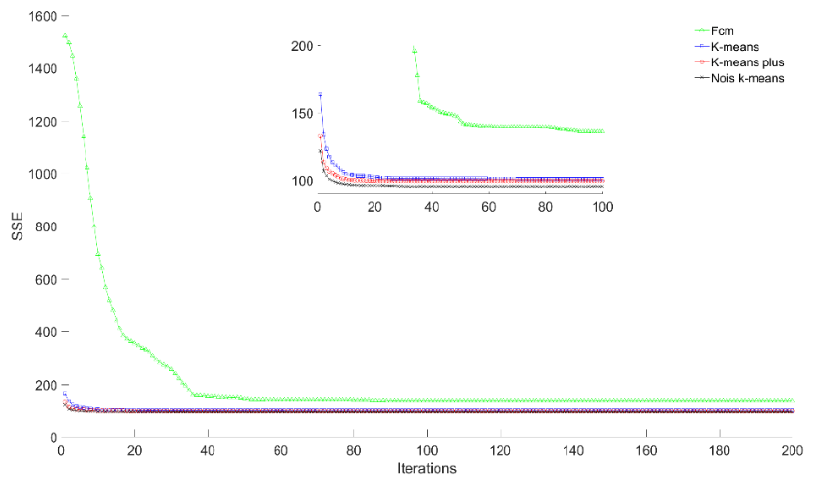
Figure 6. The SSE convergence curve for taxi GPS data (Rome (Italy)).